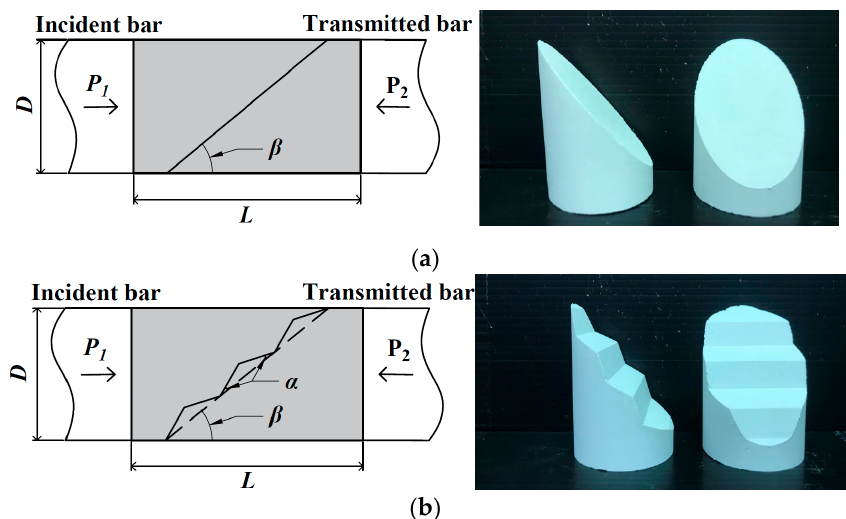
Figure 1. Specimens that contain a single planar joint ( a ) and a joint with regular triangular sawteeth asperities ( b ). D and L are the diameter and height of specimen, respectively. P 1 and P 2 are the loading directions of pressure.